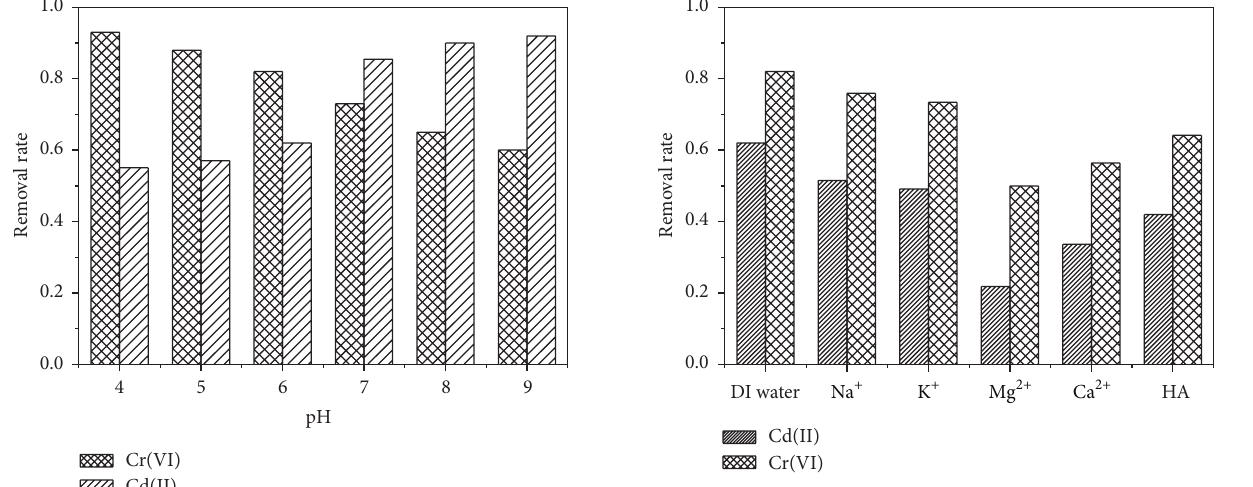
Figure 6: Effect of initial pH on Cr(VI) and Cd(II) removal by Fe@SiO 2 . Initial Cr(VI) and Cd(II) concentration: 70mg ⋅ L −1 , Fe dose: 0.15 g ⋅ L −1 , and temperature: 25 ∘ C.